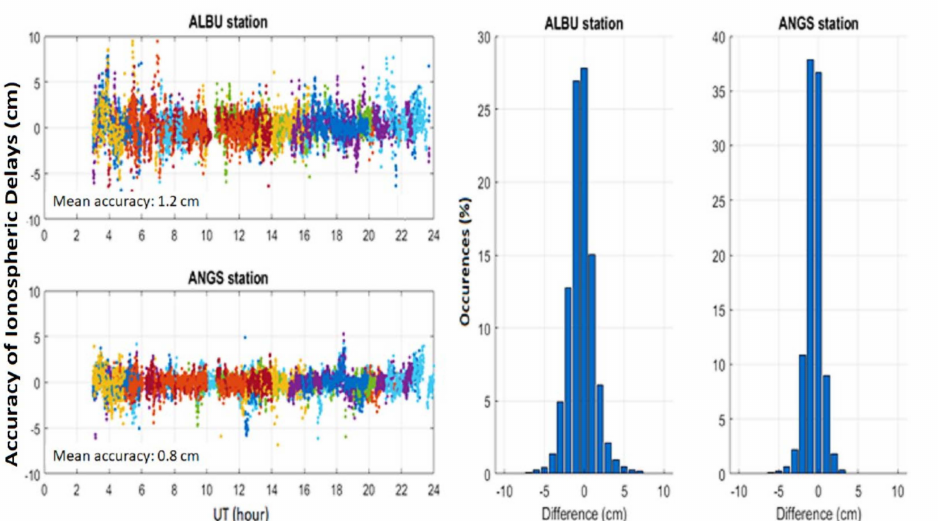
Figure 3. Results of the slant ionospheric corrections comparison at two Victorian CORS stations, ALBU and ANGS on 6 May 2021. ( Left ) Time series plots showing the precision (mean accuracy) of the SD slant ionospheric corrections of each satellite-receiver path based on linear interpolation method. ( Right ) Bar charts showing the accuracy (difference between the estimated and interpolated values) and distribution of the